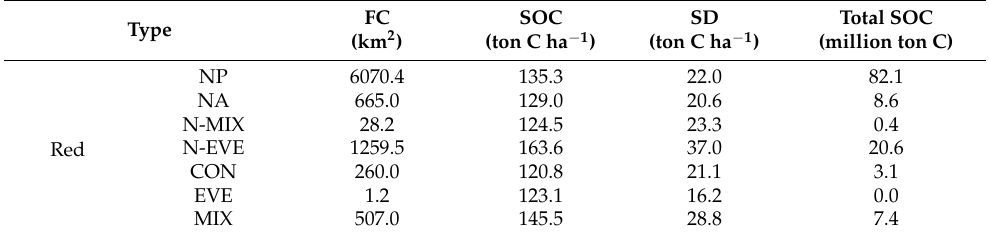
Table A2. Forest cover (FC, km 2 ), mean soil organic carbon content (SOC, ton C ha − 1 ) and